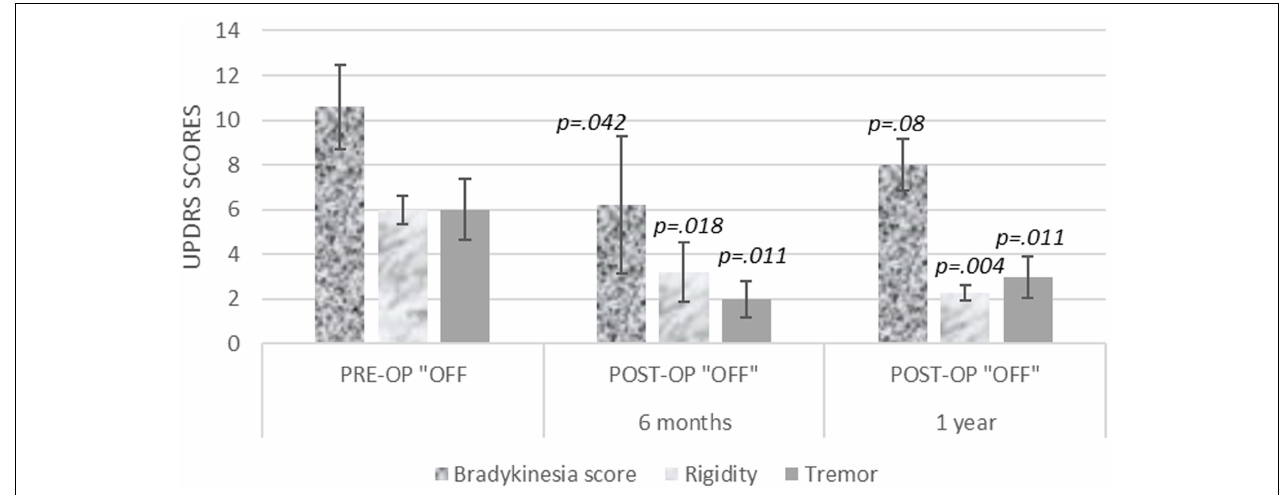
FIGURE 2 | Contralateral bradykinesia, rigidity, and tremor UPDRS scores, at 6 months and 1 year after unilateral pallidotomy.